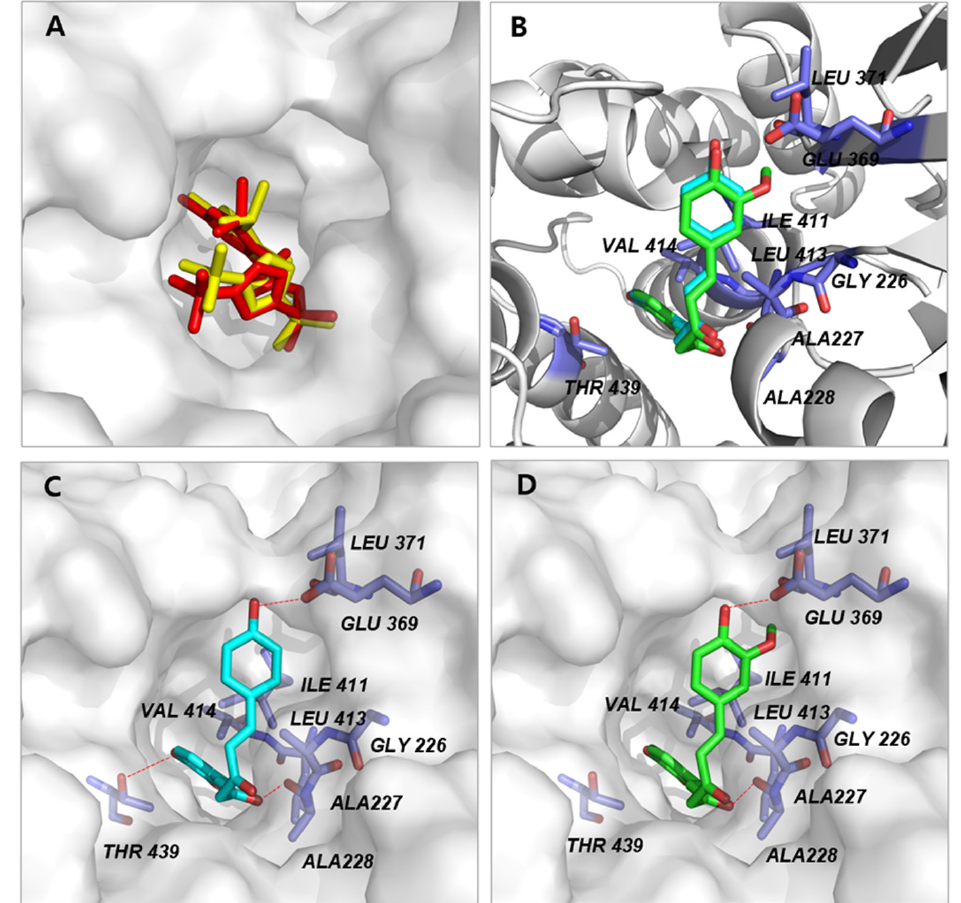
Figure 4. Molecular docking of DMC and curcumin to NLRP3 protein. ( A ) The co-crystal ligand, NP3-146 can be well re-docked into its own binding pocket with RMSD = 0.353 Å. The co-crystal NP3-146 in NLRP3 NACHT domain are indicated by the red stick. ( B ) Superimposition of predicted conformations for DMC (cyan) and curcumin (green) in the NLRP3 NACHT domain structure. ( C ) Detailed interactions between DMC and NLRP3 protein are shown as a stick model, and hydrogen bonds are indicated with red dashed lines. There are three possible hydrogen bond between DMC and NLRP3 protein, i.e., C12-OH with Glu369, C13-OH with Thr439, and the C15-OH with Ala228. ( D ) Detailed interactions between curcumin and NLRP3 protein are shown as a stick model, and H-bonds are indicated with red dashed lines. Figures were drawn by using PyMol (Delano Scientific LLC, San Carlos, CA, USA).